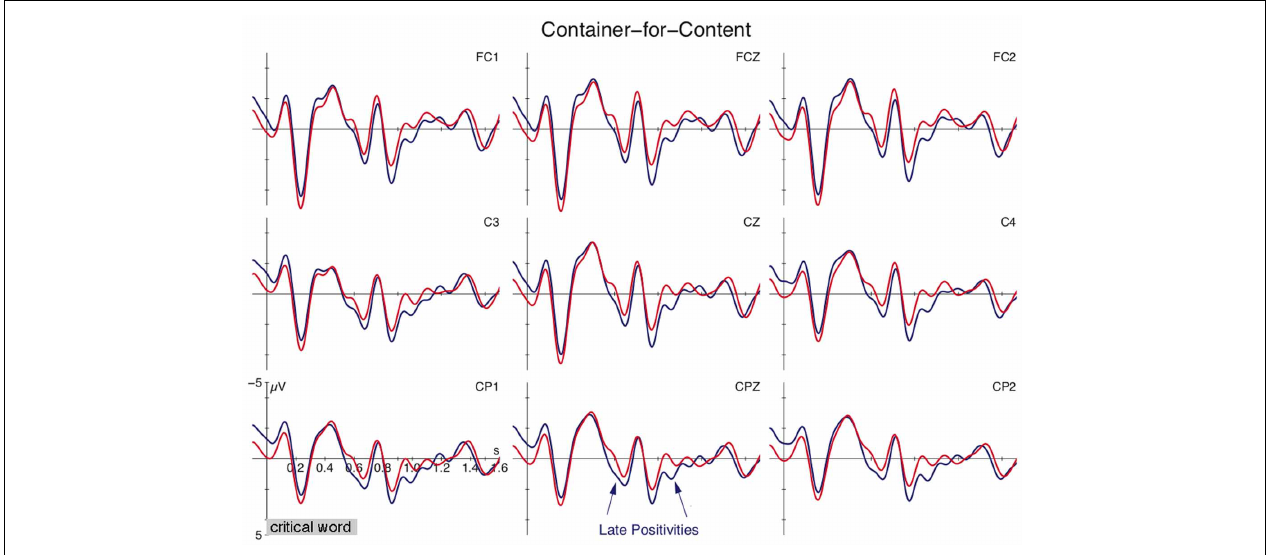
FIGURE 1 | Grand average ERPs time-locked to the critical container expression ( den Becher , “ the goblet”) at selected electrodes for the meaning shift (blue) and control condition